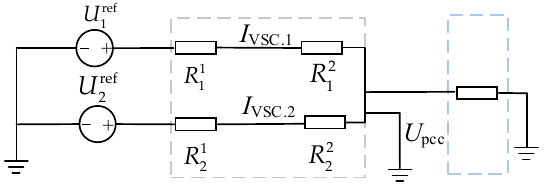
Figure 6. Simplified structure of the double parallel converters.